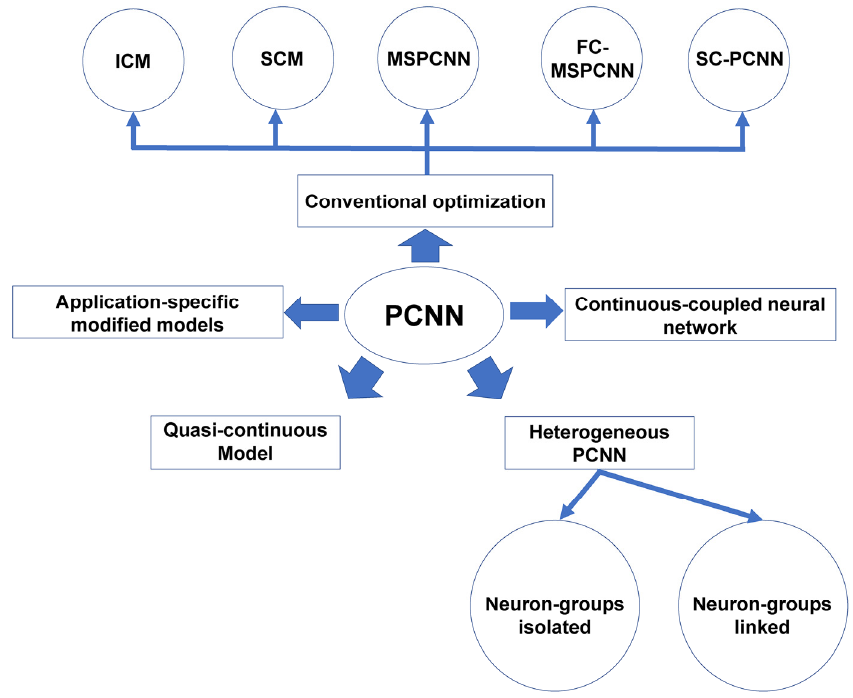
Figure 1. Framework of PCNN's development.